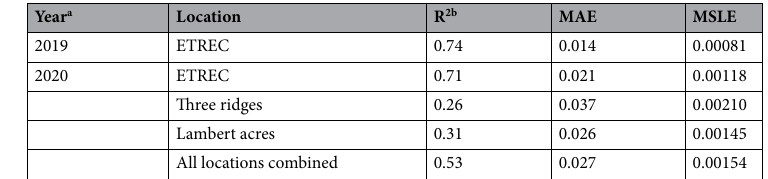
Table 1. Gompertz function to fit early season (0 to 50% yearly maximum) P. annua emergence and cooling degree day accumulation data collected at the East Tennessee AgResearch and Education Center—Plant Sciences Unit (ETREC; Knoxville, TN) in 2019 and 2020, as well as Lambert Acres Golf Course (Alcoa, TN) and Three Ridges Golf Course (Knoxville, TN) in 2020. Emergence was monitored in plots (1 m 2 ) established as a hybrid bermudagrass ( C. dactylon L. Pers . x C. transvaalensis Burtt-Davy) on a weekly basis. a Early season P. annua emergence data and cooling degree days (CDD 21C ) accumulation data were fit to the following Gompertz function each year: Emergence (%) = 0.485 × exp (− 12.141 × exp(− 0.081× CDD 21C )). b Model fit was assessed using coefficient of determination (R 2 ), mean absolute error (MAE), and mean squared log